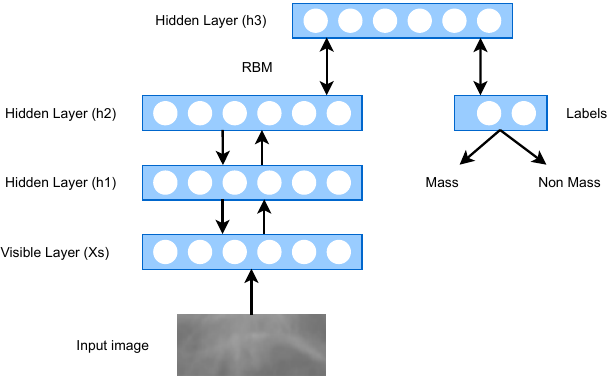
Figure 5. An illustration of the DBN model for breast-cancer diagnosis. Abdel-Zaher and Eldeib [54] proposed a CAD scheme for the detection of